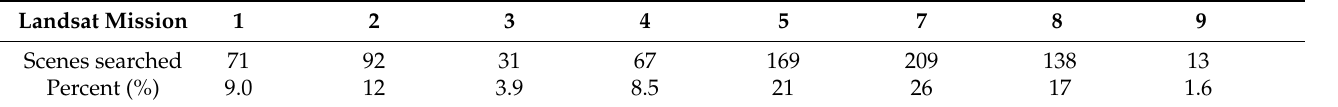
Figure 2. Example of an unrecorded tundra fire, the 2010 Lepidozia fire (4.5 ha), in a sequence of Landsat scenes overlaying background imagery. ( a ) 5 June 2010, prior to ignition. ( b ) 12 June 2010, several days after ignition. ( c ) 23 August 2010 and ( d ) 7 June 2011; these images are ideal and confirm the burn. ( e ) 9 August 2011 and ( f ) 13 August 2012; the burn has faded. These scenes illustrate various scene defects, such as incomplete swaths in Landsat 7 due to “Scan Line Corrector Failure” ( a , b , e , f ), obscuring white cloud in the air (the white wisp south of the burn in ( b )), and dark cloud shadow on the ground ( b , e ). There is snow in the watertracks in a and d . The images are from Landsat Mission 5 ( c , d ) and Mission 7 ( a , b , e , f ). The edge length of each scene is 2 km. The image contrast has been increased for clarity. Table 1. Landsat search